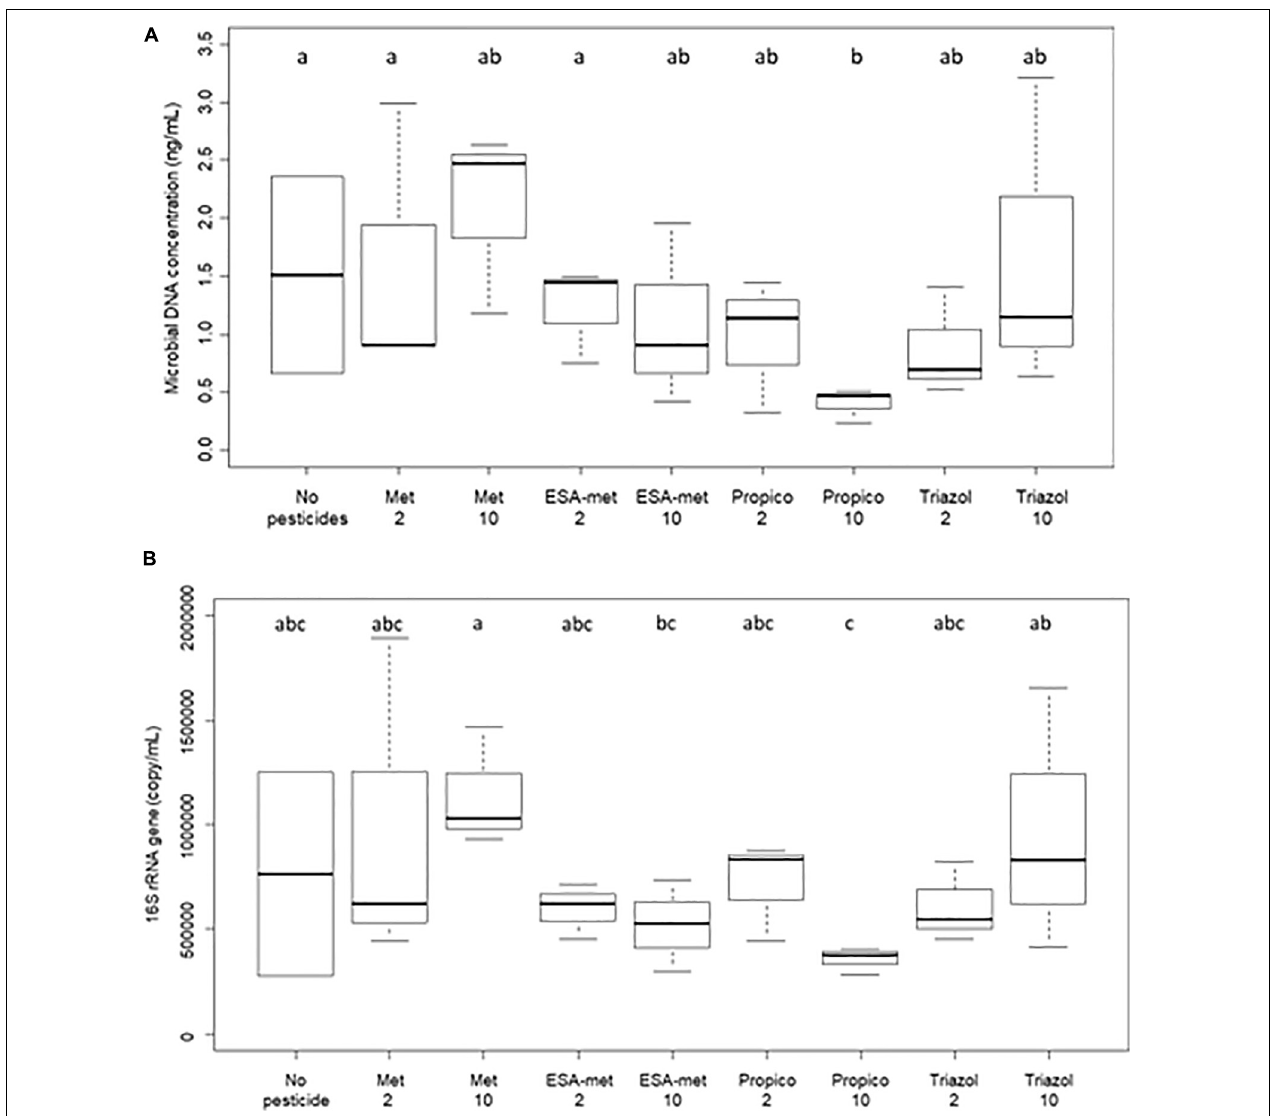
FIGURE 6 | Biomass quantification in flasks at the end of batch experiments. (A) Molecular biomass (measured as total DNA concentration) and (B) bacterial biomass (measured as bacterial 16S rRNA gene copies). No pesticide: control (absence of pesticides or metabolites); Met: metolachlor; ESA-met: ESA- metolachlor; Propico: propiconazole; Triazol: 1,2,4-triazole. 2 and 10 are pesticide or metabolite concentrations in µ g/L. Significant differences between conditions were searched applying the Kruskal–Wallis non- parametric test and are mentioned as a, b, and c